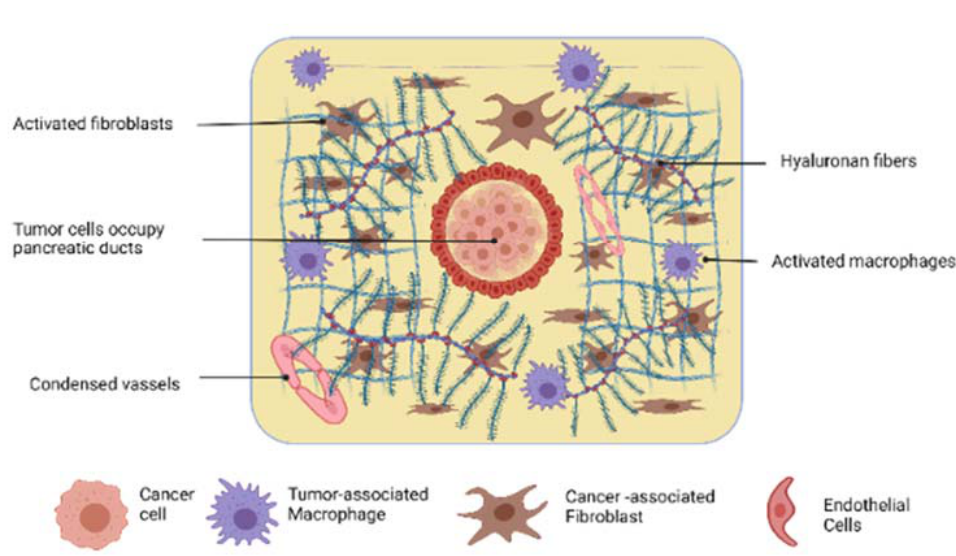
Figure 2. The PDAC microenvironment. Created with BioRender.com.